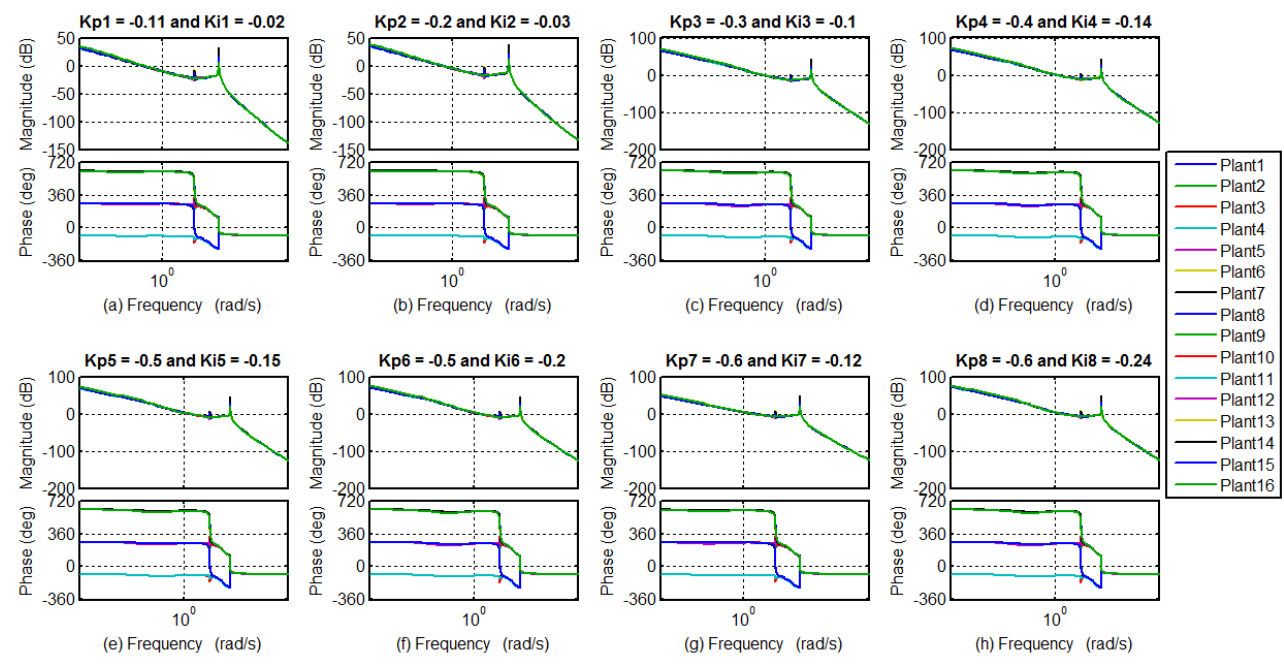
Figure 12. The frequency responses of 16-Kharitonov plants with Kp and Ki values considered from Figure 6. From figures a to h all the 16 Kharitonov plants achieved a minimum of 30 0 phase margin and atleast 11 dB gain margin.